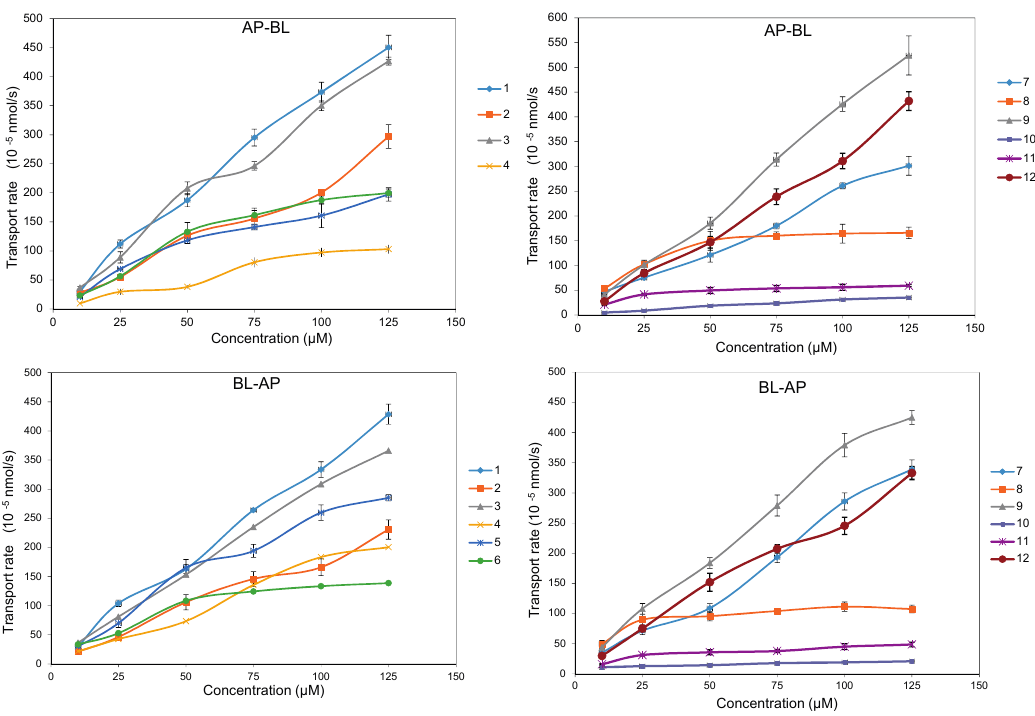
Figure 4. The bidirectional transport rate of twelve coumarins in MDCK-pHaMDR cell monolayer as a function of concentration at 10–125 μ M. Data are the mean ± S.D. ( n = 6).